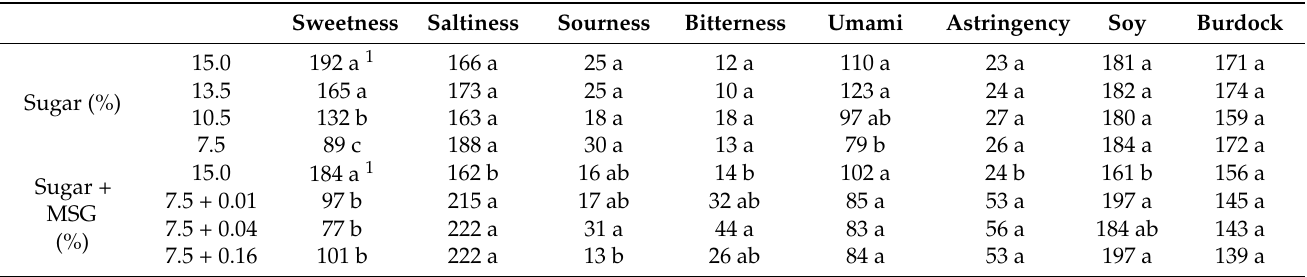
Table 5. RATA counts according to sugar or sugar with MSG concentrations for simmered bur- dock